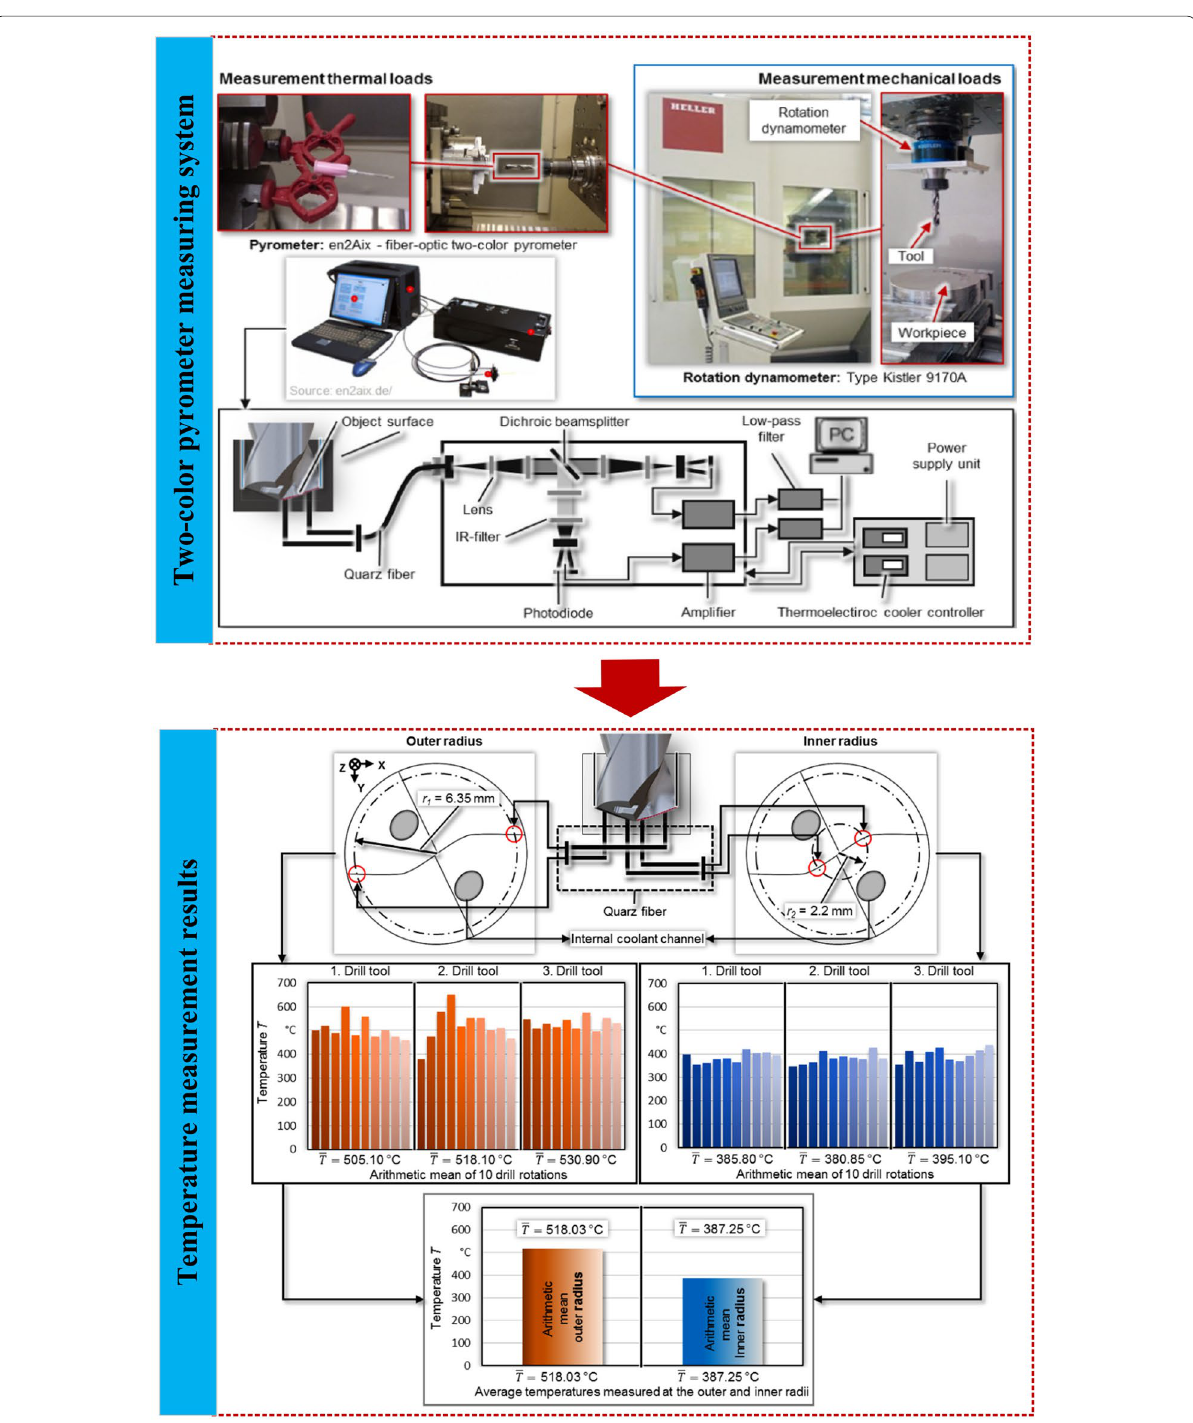
Figure 11 Two-color pyrometer temperature measuring system and temperature measurement result